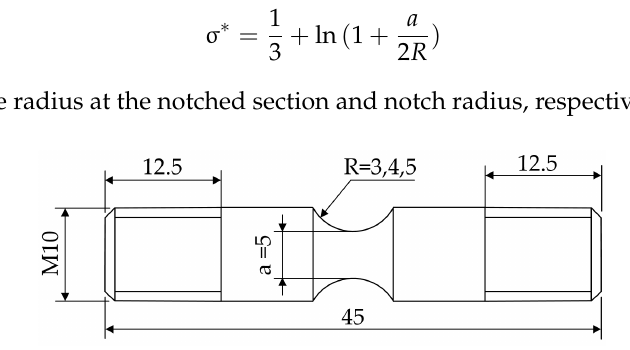
Figure 4. Notched sample for the specified triaxiality (units: mm).